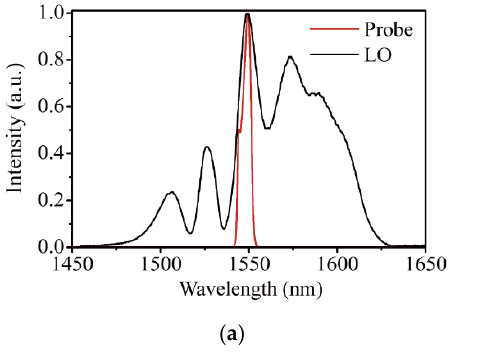
Figure 7. ( a ) Optical spectrum of the two nonlinear polarization evolution (NPE) lasers; ( b ) autocor- relation traces of the two NPE lasers.